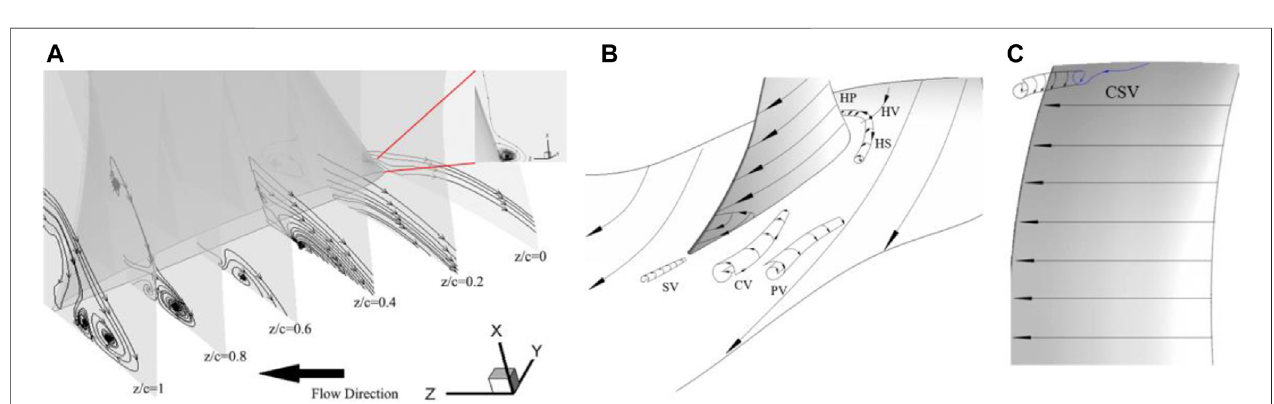
FIGURE 14 | Spatial structure of vortex